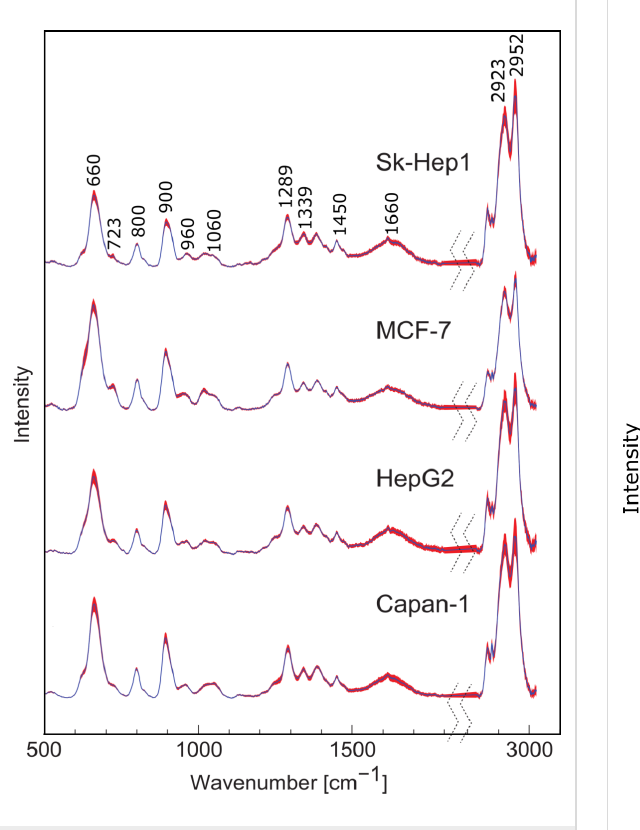
Figure 3: Preprocessed mean SERS spectra and standard deviations of the different cell lines. Labeled bands are assigned to cellular bio- molecules including nucleic acids, proteins and carbohydrates. The low standard deviation values (represented by the red shadow) em- phasize the high reproducibility of the technique.